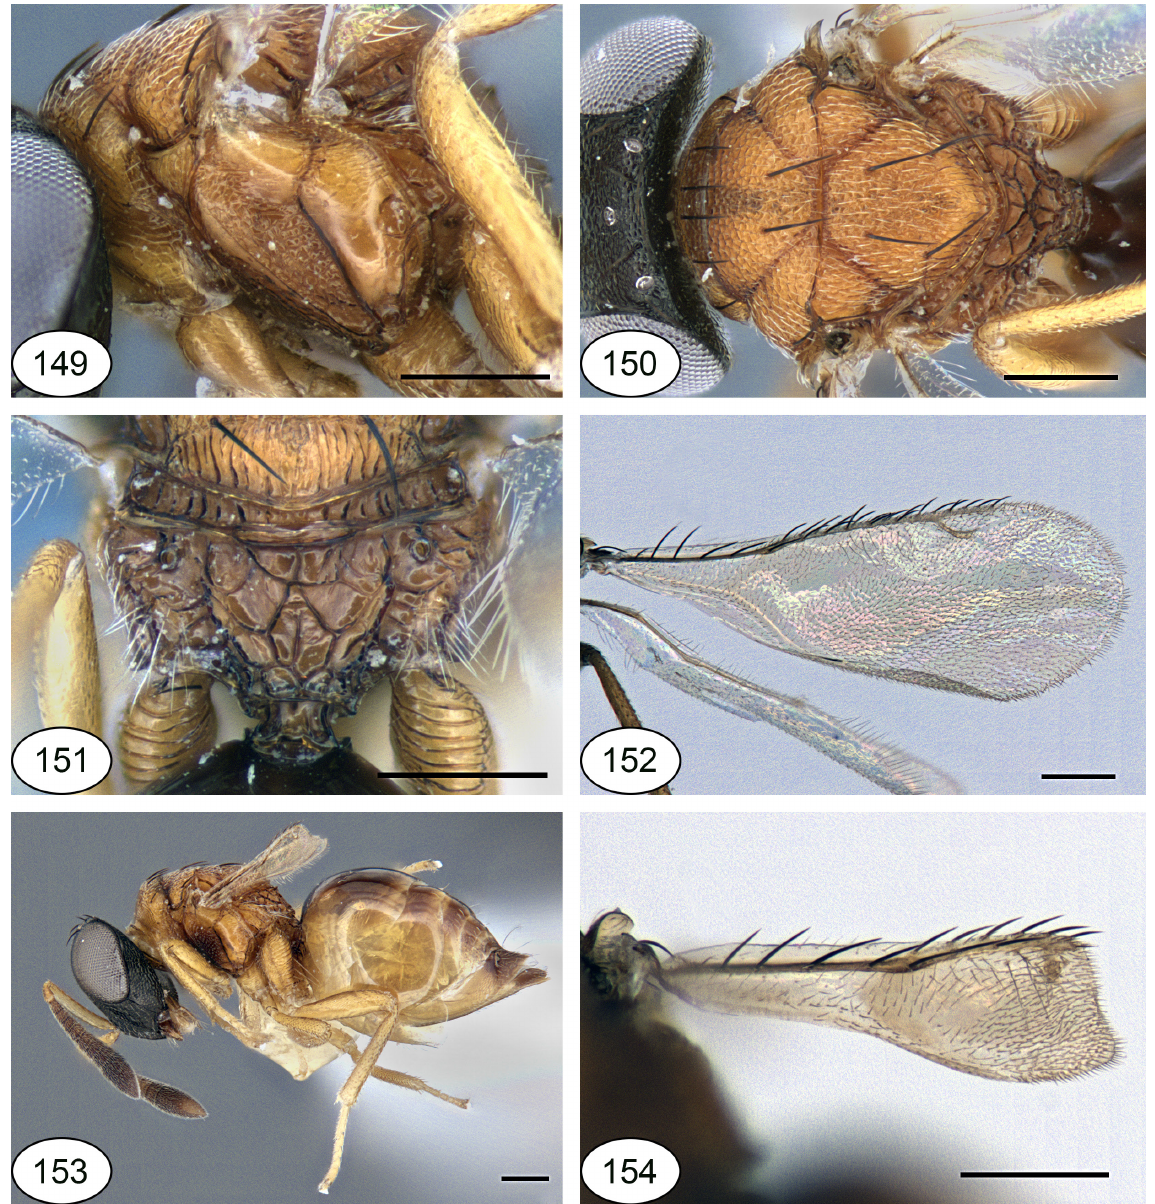
Figs 149–154. Netomocera ramakrishnai Sureshan, 2010. 149 . ♀, Taiwan, mesosoma, lateral view. 150 . ♀, Taiwan, mesosoma, dorsal view. 151 . ♀, Taiwan, propodeum, dorsal view. 152 . ♀, Taiwan, fore wing. 153 . ♀, Japan, habitus, lateral view. 154 . ♀, Japan, fore wing. Scale bars: 0.2